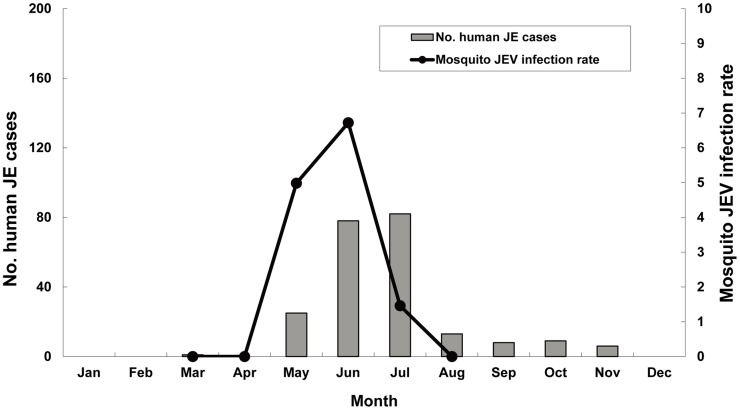
Japanese encephalitis epidemic season in humans and MLE of the JEV infection rates in mosquitoes by month during 2005–2012.